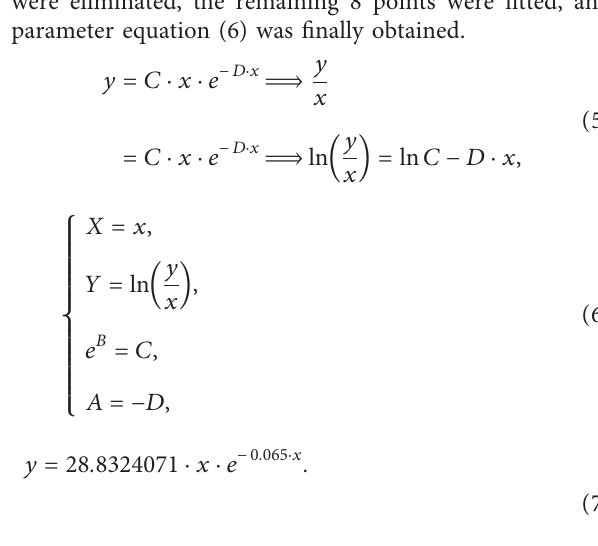
Figure 14, using the custom function compilation function of ORIGIN 2019 Pro, the new function y � a ∗ x ∗ (exp ( − B ∗